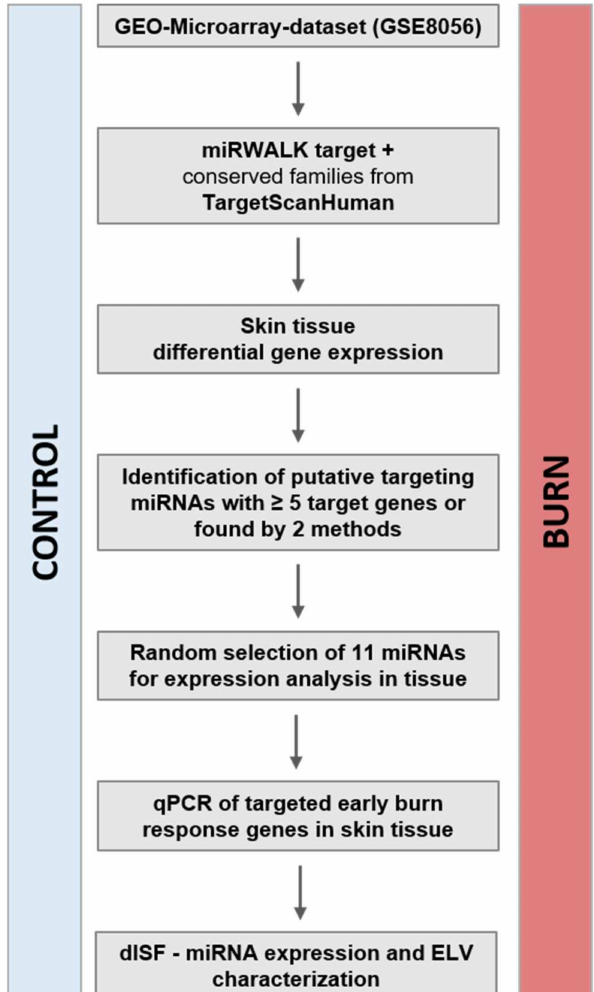
Figure 1. Study concept and workflow. From the publicly available dataset of GSE8056, we compared the groups for control (no burn) and the sample pools of up to 3 days after the burn wound. The genes with a p adj < 0.001 were considered the genes of the early burn response. The miRNAs putatively targeting these mRNAs were identified via the bioinformatics approach (miRWalk target, TargetScan- Human). Selected miRNAs and the early burn response genes they target were analyzed in a human skin model for burn injuries. The miRNAs in human dISF were characterized. Abbreviations: GEO, Gene Expression Omnibus; miRNA, microRNA; qPCR, real-time quantitative PCR; p adj , adjusted p -value; dISF, dermal interstitial fluid; ELV, exosome-like